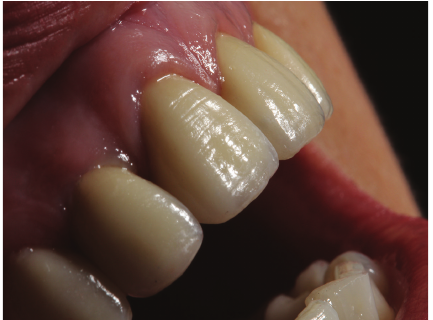
Figure 11: Silane application.